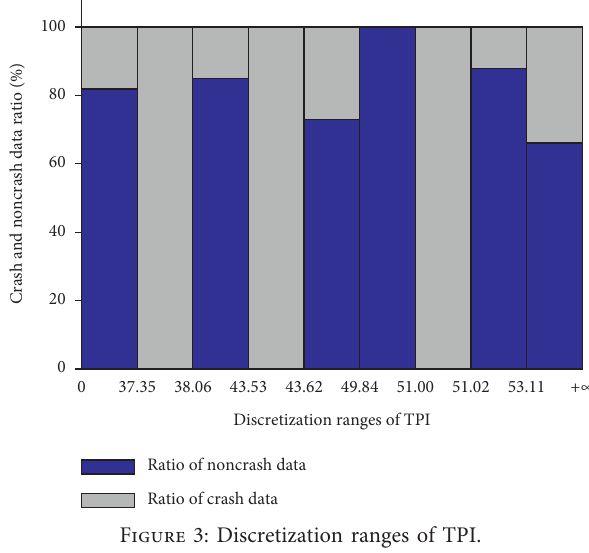
Figure 3: Discretization ranges of TPI.